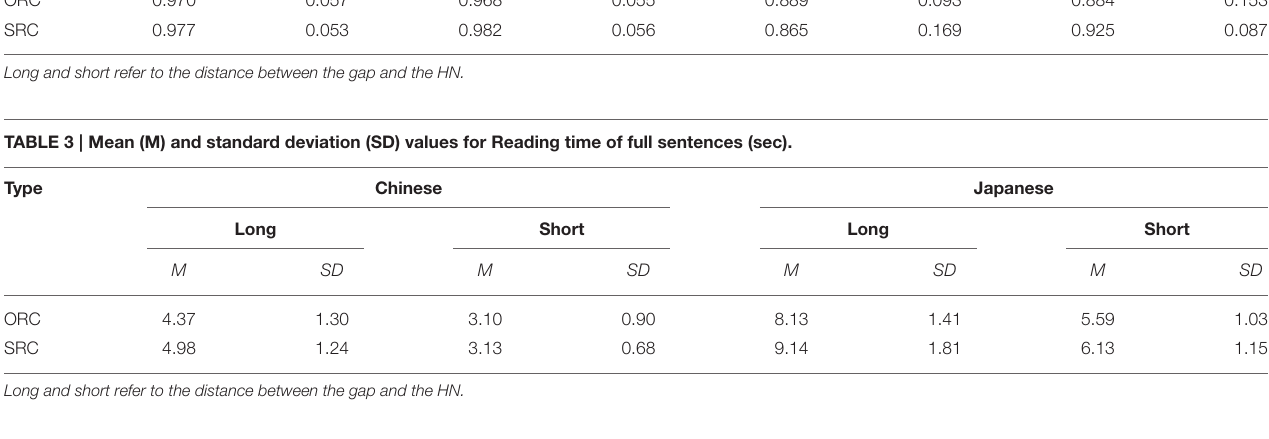
Long and short refer to the distance between the gap and the HN.